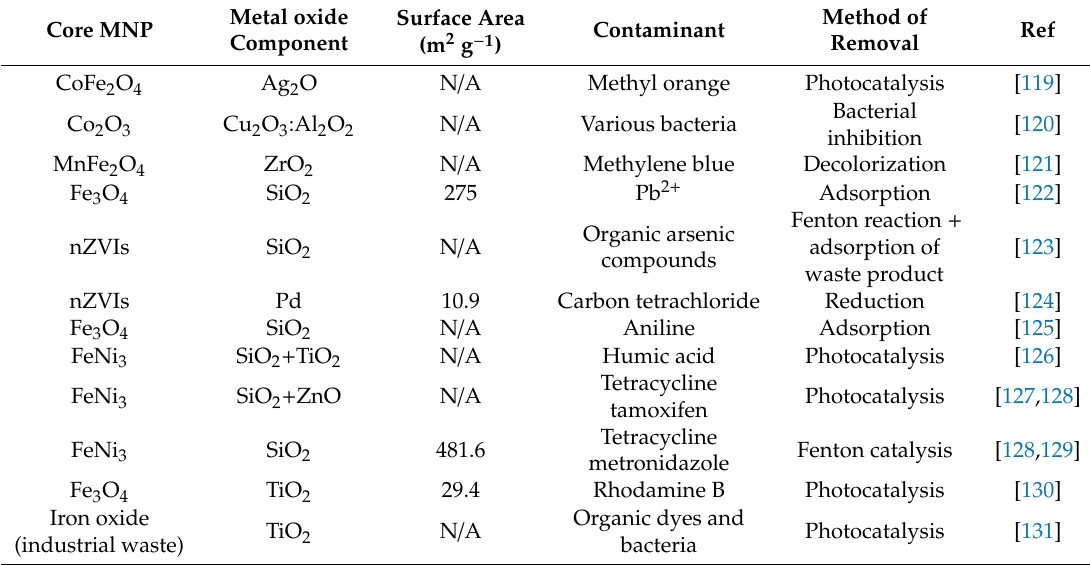
Table 7. Examples of magnetic nanocomposites formed with inorganic materials such as metals, metal oxides and metal organic